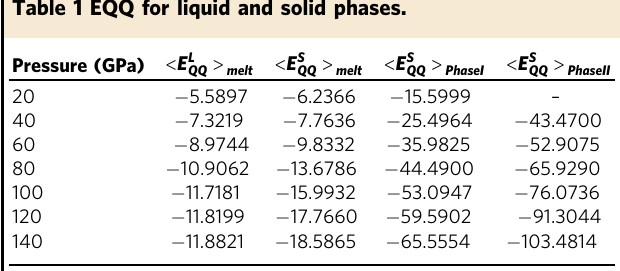
Table 1 EQQ for liquid and solid